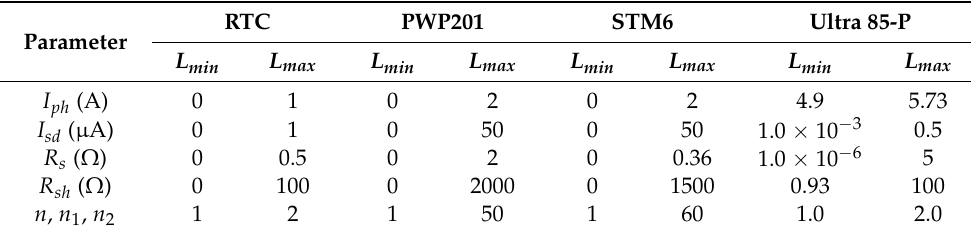
Table 2. The search boundaries of each unknown